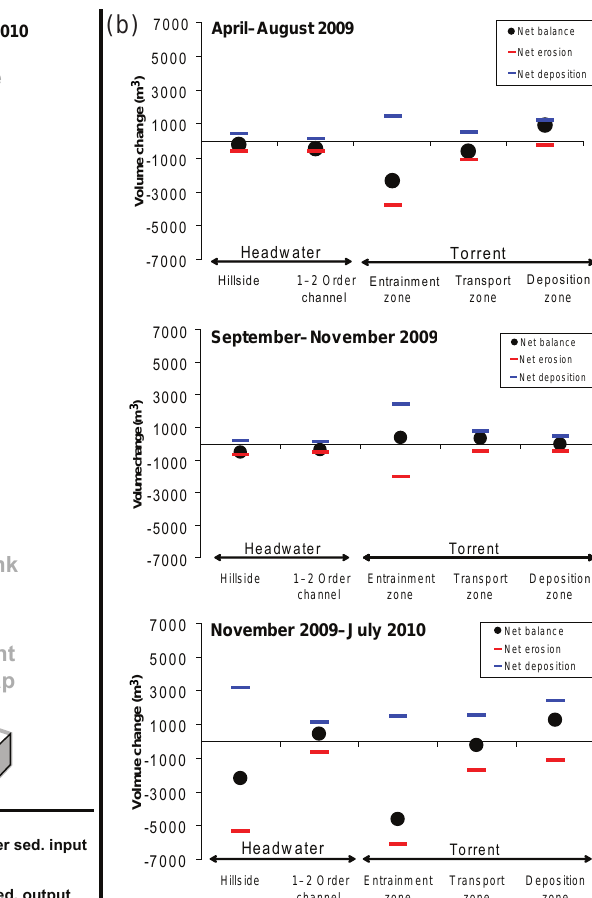
Fig. 6 Storage changes for the three peri- ods showing sediment transfers from debris source zone to the apex of the fan.